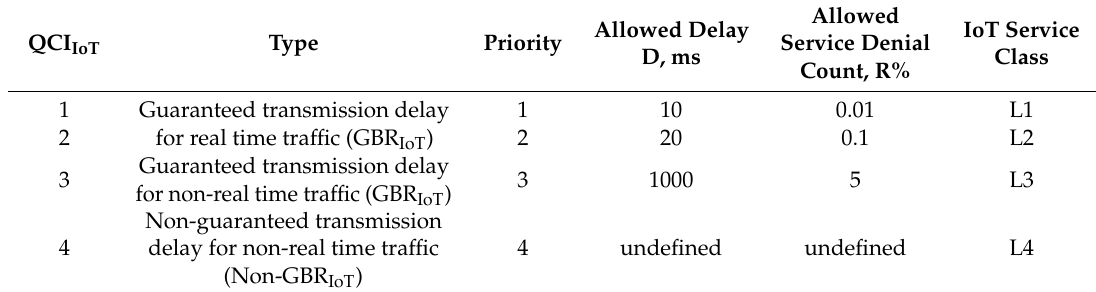
Table 1. Characteristics of Quality of Service Class Identifier IoT (QCI IoT